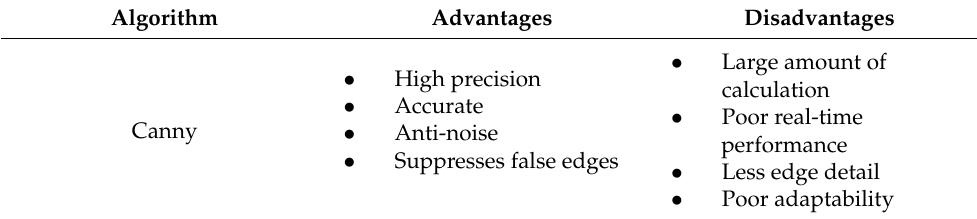
Table 2. Comparison of edge detection